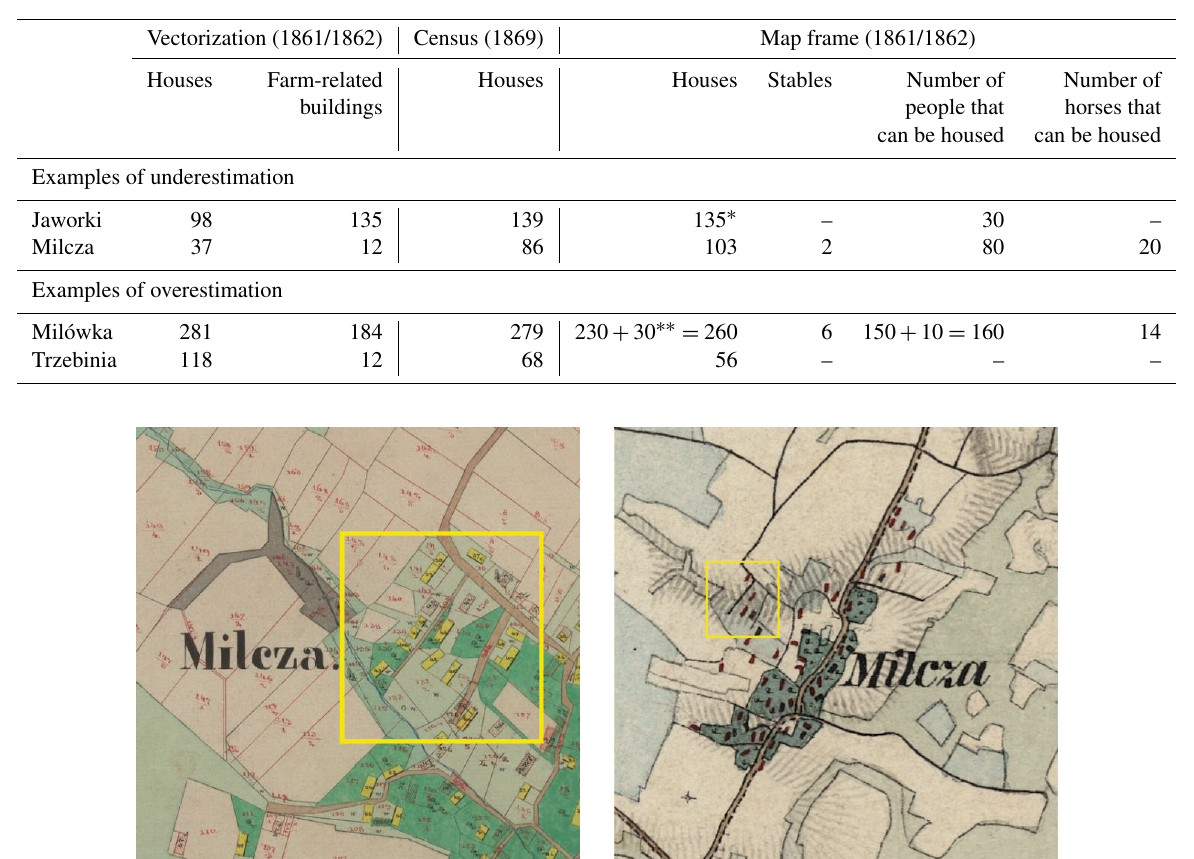
Table 4. Number of houses captured in our database related to the census data and map frame information – examples of underestimation and overestimation. ∗ Summary of two cadastral villages, Jaworki I Theil and Jaworki II Theil; ∗∗ houses for Milówka, and Sucha Góra also covered.